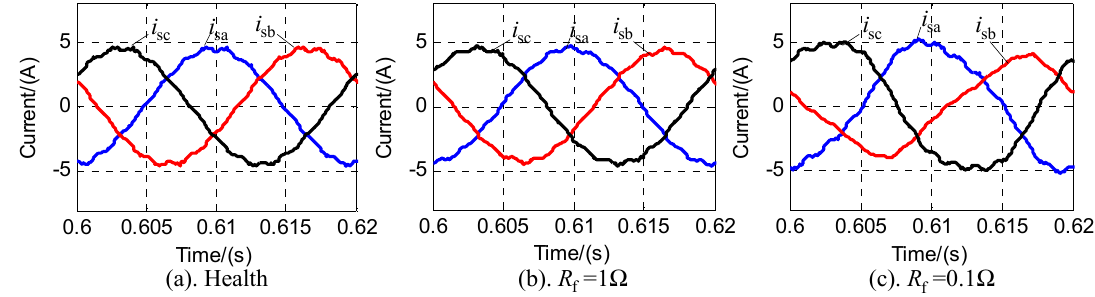
Figure 10. Currents of stator phases for 5 turns shorted stator fault with different fault resistances.